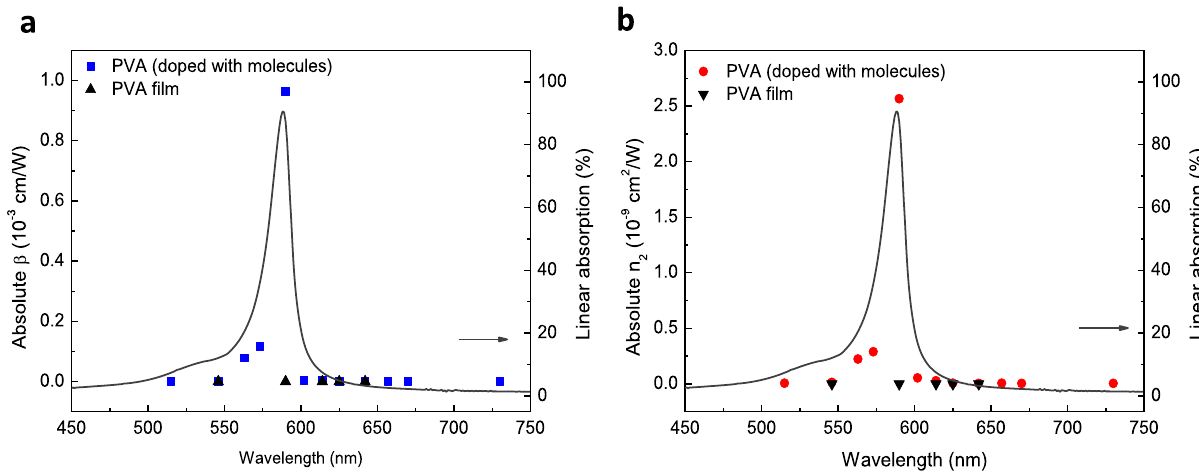
Fig. 4 Nonlinear coef fi cients of PVA fi lm with and without molecule doping. Absolute values of ( a ) nonlinear absorption coef fi cient and ( b ) nonlinear refractive index of the PVA fi lm with (blue squares and red circles) and without molecules (black triangles), respectively. The gray solid curves represent the linear absorption spectrum of the